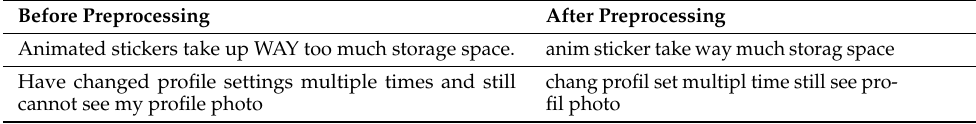
Table 7. Data samples before and after